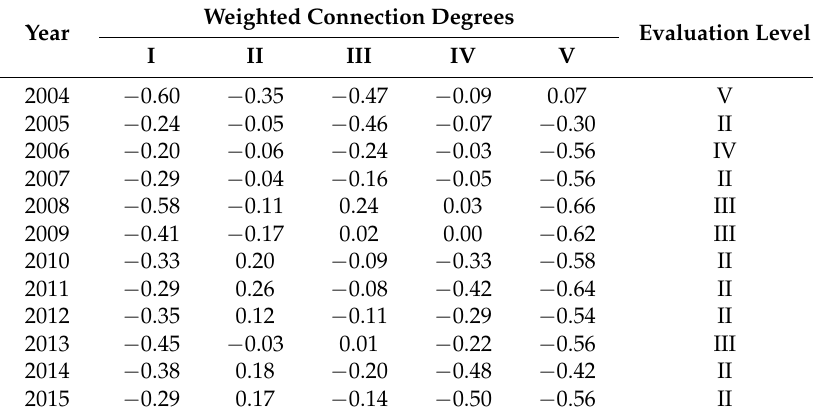
Table 9. The weighted connection degrees and evaluation